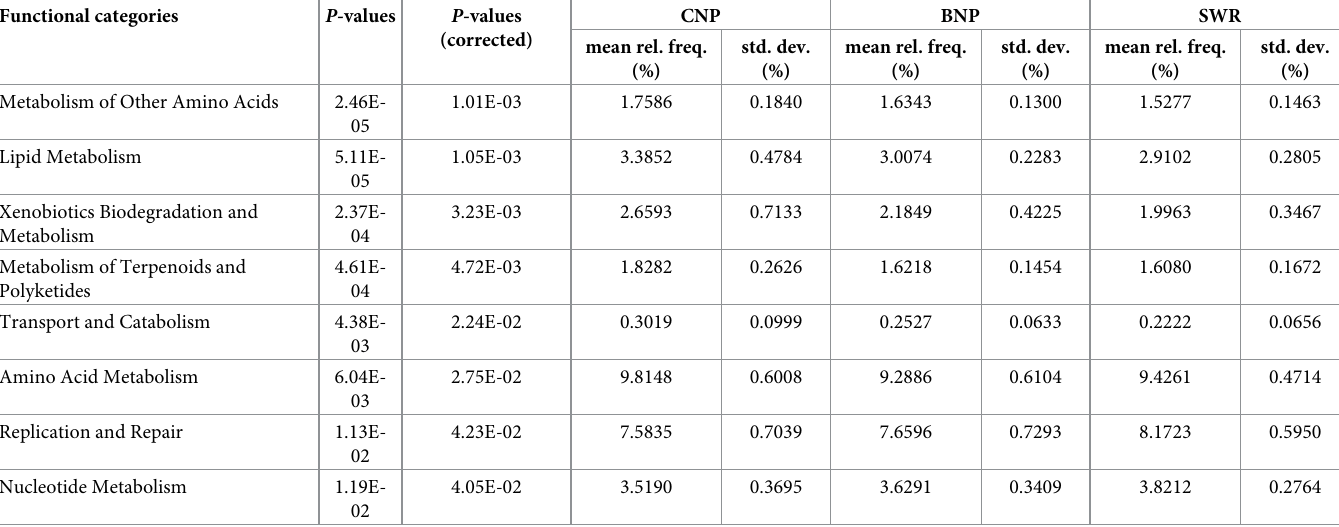
Table 4. Predictive functional profiling of microbial communities using multiple-group comparative PICRUSt analysis ( P -value corrected <